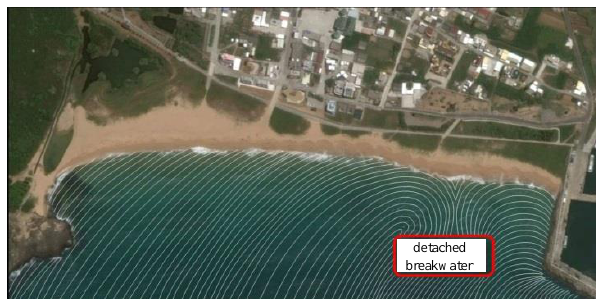
Figure 9. The simulation of wave crest after the placement